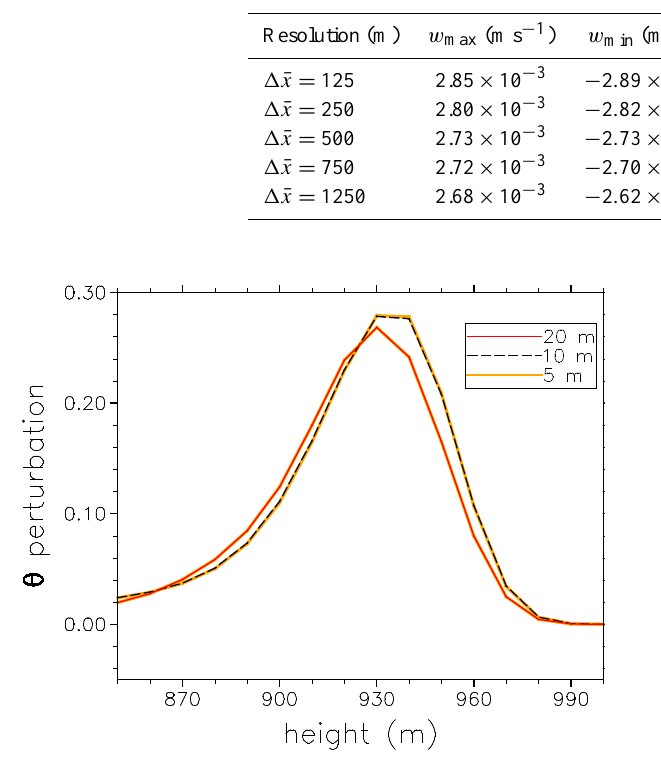
Figure 12. Vertical profiles of the potential temperature perturba- FIG. 12. Vertical profiles of the potential temperature perturbation for the rising thermal 2 tion for the rising thermal bubble test at x = 500 m after 700s bubble test at x = 500 m after 700 s for various resolutions: , 20x z ∆ ∆ = m (thin solid line), 3 for various resolutions: (cid:49) ¯ x,(cid:49) ¯ z = 20m (thin solid line), (cid:49) ¯ x,(cid:49) ¯ z = , 10x z ∆ ∆ = m (thin dashed line), and , 5x z ∆ ∆ = m (thick solid line). 4 10m (thin dashed line), and (cid:49) ¯ x,(cid:49) ¯ z = 5m (thick solid line).